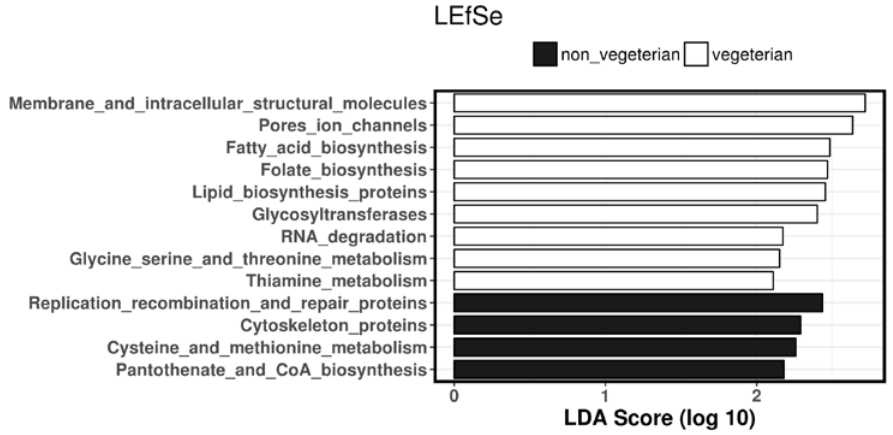
Figure 4. Predicted biosynthesis function analyses.